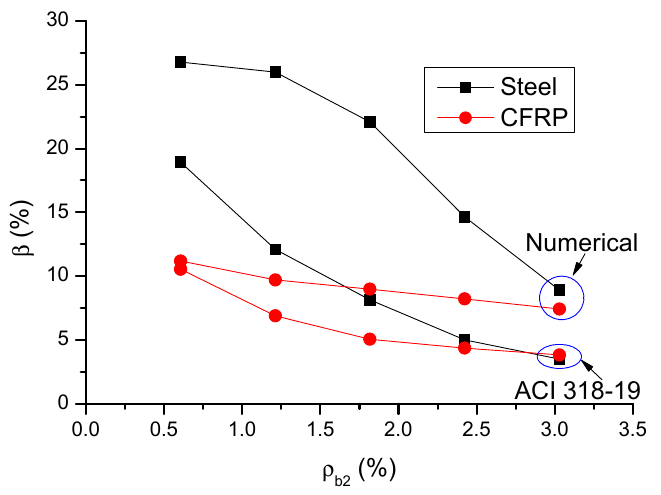
Figure 16. Comparison between numerical and ACI 318-19 predictions regarding the β – ρ b 2 relation- ship.